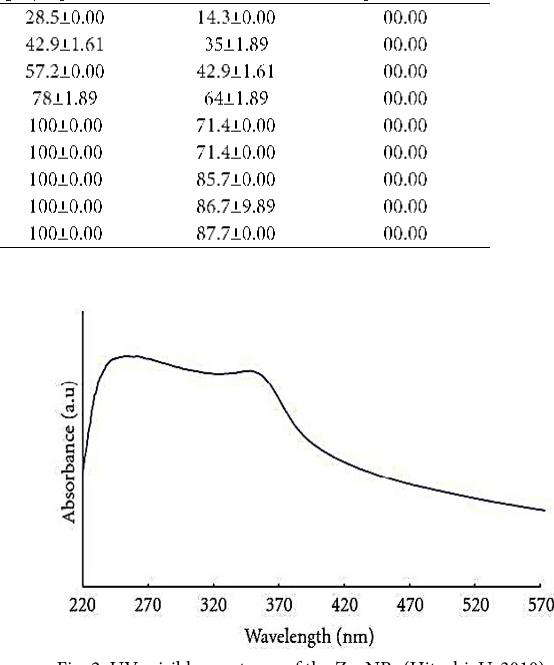
Fig. 1. TEM image of 15 nm Zn-NP Fig. 2. UV- visible spectrum of the Zn-NPs (Hitachi,